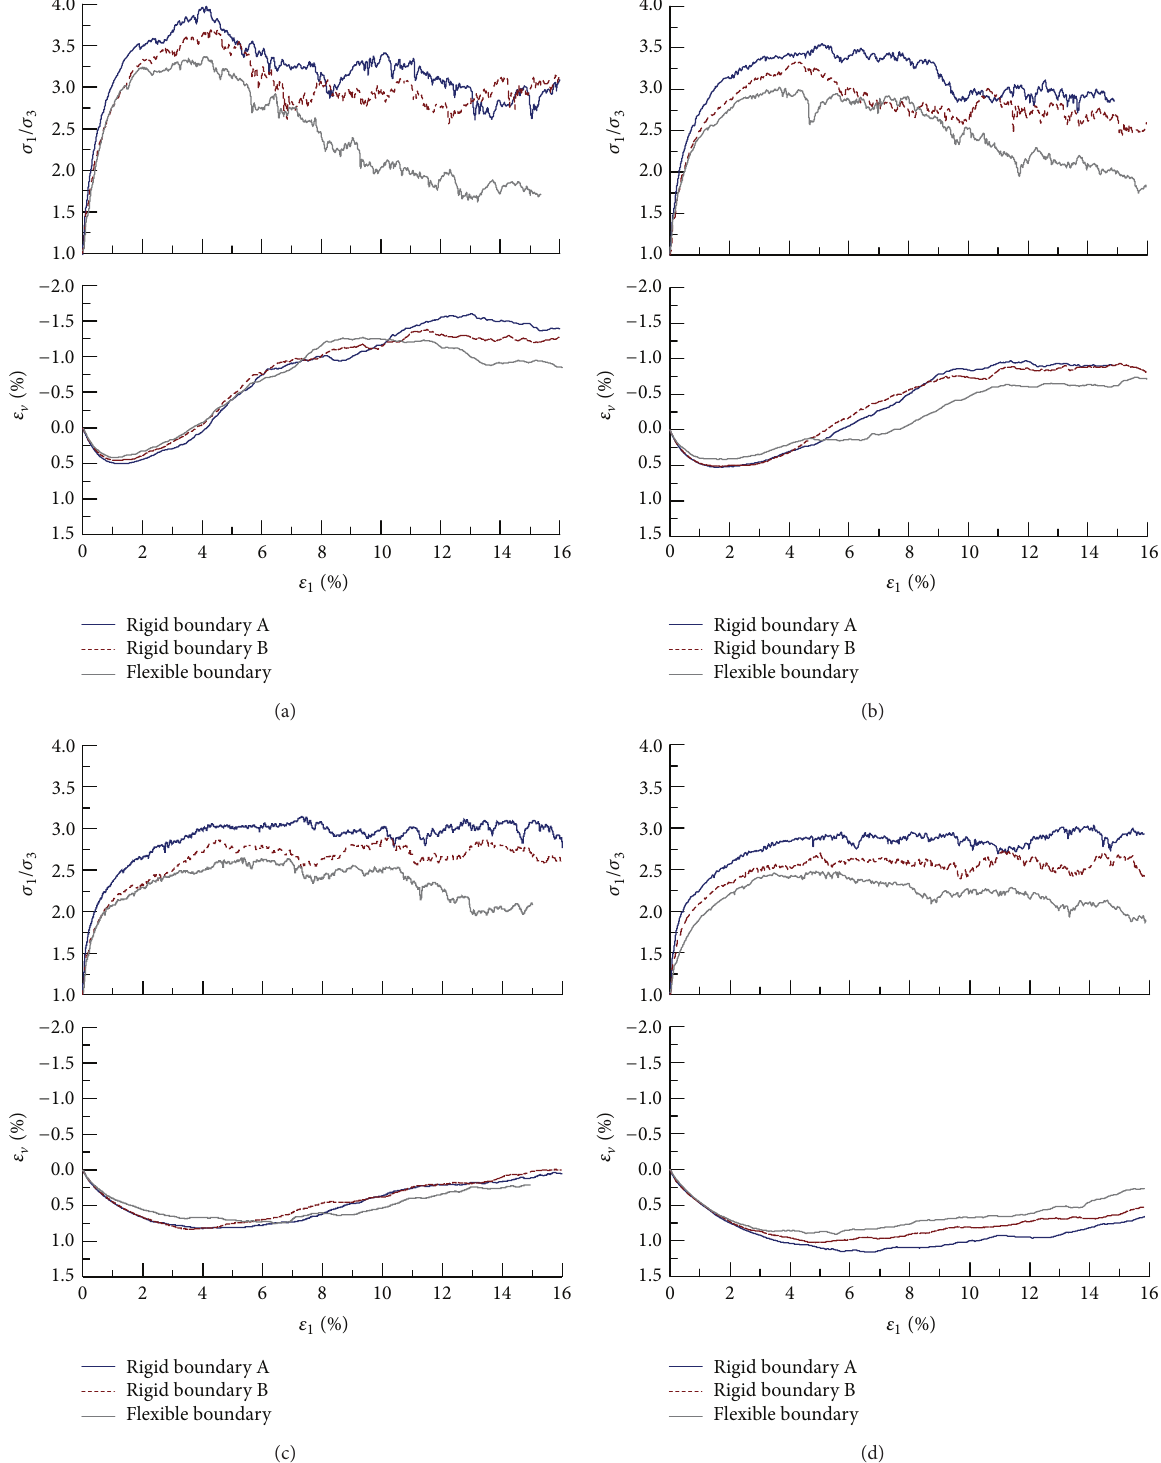
Figure 8: The development of stress ratio 𝜎 1 /𝜎 3 and volumetric strain 𝜀 V with axial strain 𝜀 1 for three different boundary conditions: (a) 𝛿 = 0 ∘ , (b) 𝛿 = 30 ∘ , (c) 𝛿 = 60 ∘ , and (d) 𝛿 = 90 ∘